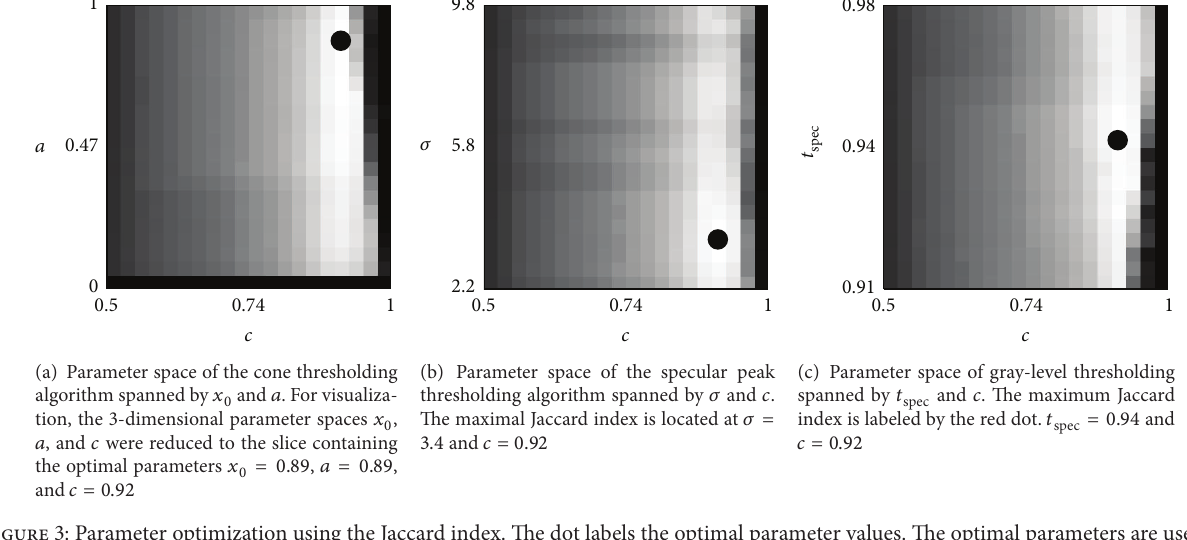
(b) Parameter space of the specular peak thresholding algorithm spanned by 𝜎 and 𝑐 . The maximal Jaccard index is located at 𝜎 = 3.4 and 𝑐 = 0.92